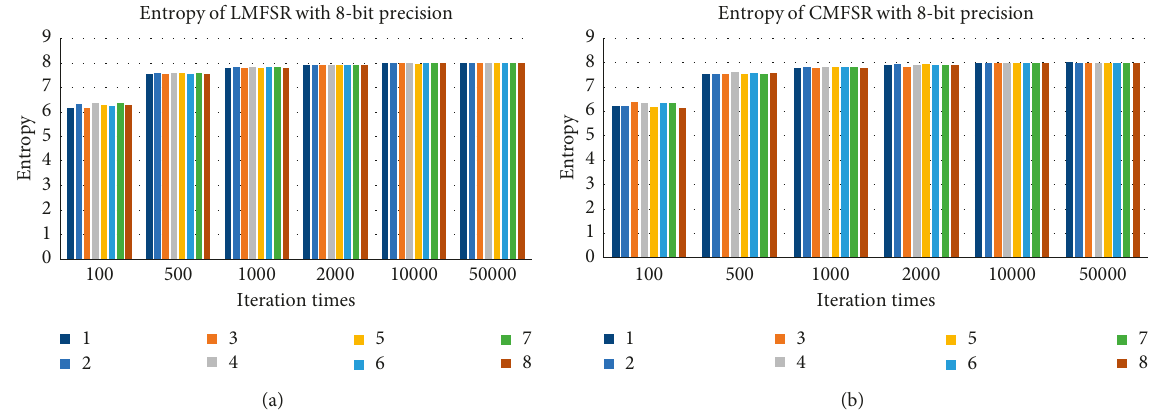
Figure 9: Entropy of CMFSR with different initial values. (a) Entropy of LMFSR with 8-bit precision. (b) Entropy of CMFSR with 8-bit